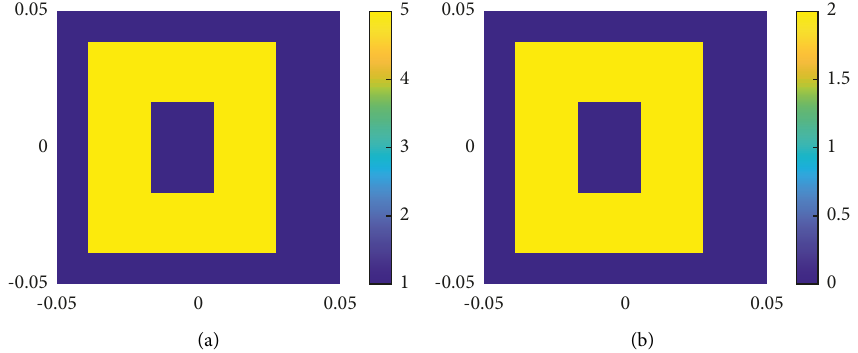
Figure 19: Inversion results obtained by hybrid algorithm in [11]. (a) Real part. (b) Imaginary part.